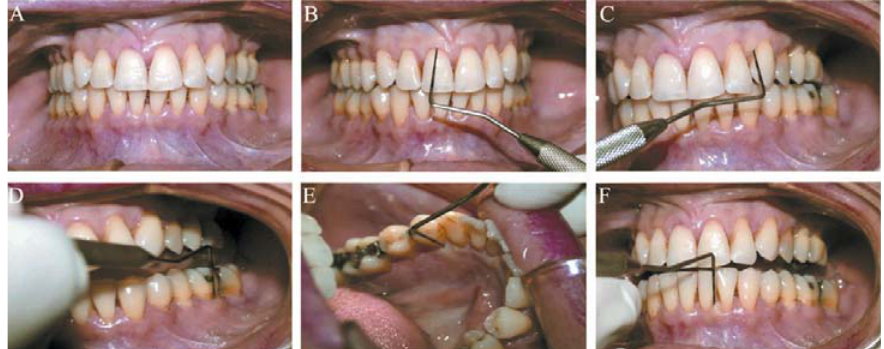
Figure 1- (cid:2)(cid:3)(cid:4)(cid:5)(cid:6)(cid:5)(cid:7)(cid:8)(cid:4)(cid:2)(cid:9)(cid:10)(cid:8)(cid:11)(cid:12)(cid:13)(cid:10)(cid:14)(cid:2)(cid:15)(cid:9)(cid:2)(cid:11)(cid:16)(cid:10)(cid:2)(cid:6)(cid:15)(cid:6)(cid:17)(cid:5)(cid:6)(cid:18)(cid:8)(cid:19)(cid:19)(cid:8)(cid:11)(cid:15)(cid:13)(cid:20)(cid:2)(cid:21)(cid:10)(cid:14)(cid:11)(cid:13)(cid:12)(cid:7)(cid:11)(cid:5)(cid:22)(cid:10)(cid:2)(cid:23)(cid:10)(cid:13)(cid:5)(cid:15)(cid:21)(cid:15)(cid:6)(cid:11)(cid:8)(cid:4)(cid:2)(cid:21)(cid:5)(cid:14)(cid:10)(cid:8)(cid:14)(cid:10)(cid:2)(cid:24)(cid:25)(cid:26)(cid:27)(cid:28)(cid:27)(cid:29)(cid:2)(cid:7)(cid:8)(cid:14)(cid:10)(cid:30)(cid:2)(cid:28)(cid:10)(cid:13)(cid:5)(cid:15)(cid:21)(cid:15)(cid:6)(cid:11)(cid:8)(cid:4)(cid:2)(cid:11)(cid:5)(cid:14)(cid:14)(cid:12)(cid:10)(cid:14)(cid:2)(cid:31)(cid:10)(cid:13)(cid:10)(cid:2) (cid:10)(cid:22)(cid:8)(cid:4)(cid:12)(cid:8)(cid:11)(cid:10)(cid:21)(cid:2)(cid:9)(cid:15)(cid:13)(cid:2)(cid:21)(cid:10)(cid:11)(cid:10)(cid:13)(cid:19)(cid:5)(cid:6)(cid:8)(cid:11)(cid:5)(cid:15)(cid:6)(cid:2)(cid:15)(cid:9)(cid:2)(cid:23)(cid:13)(cid:15)!(cid:5)(cid:6)"(cid:2)(cid:21)(cid:10)(cid:23)(cid:11)(cid:16)#(cid:2)!(cid:4)(cid:10)(cid:10)(cid:21)(cid:5)(cid:6)"(cid:2)(cid:15)(cid:6)(cid:2)(cid:23)(cid:13)(cid:15)!(cid:5)(cid:6)"(cid:2)(cid:8)(cid:6)(cid:21)(cid:2)"(cid:5)(cid:6)"(cid:5)(cid:22)(cid:8)(cid:4)(cid:2)(cid:5)(cid:6)(cid:18)(cid:8)(cid:19)(cid:19)(cid:8)(cid:11)(cid:5)(cid:15)(cid:6)(cid:30)(cid:2)$(cid:8)(cid:11)(cid:5)(cid:14)(cid:9)(cid:8)(cid:7)(cid:11)(cid:15)(cid:13)(cid:20)(cid:2)(cid:15)(cid:13)(cid:8)(cid:4)(cid:2)(cid:16)(cid:20)"(cid:5)(cid:10)(cid:6)(cid:10)#(cid:2) with no apparent plaque formation, accumulation of gross calculus or gingivitis was observed (A). Absence of bleeding on